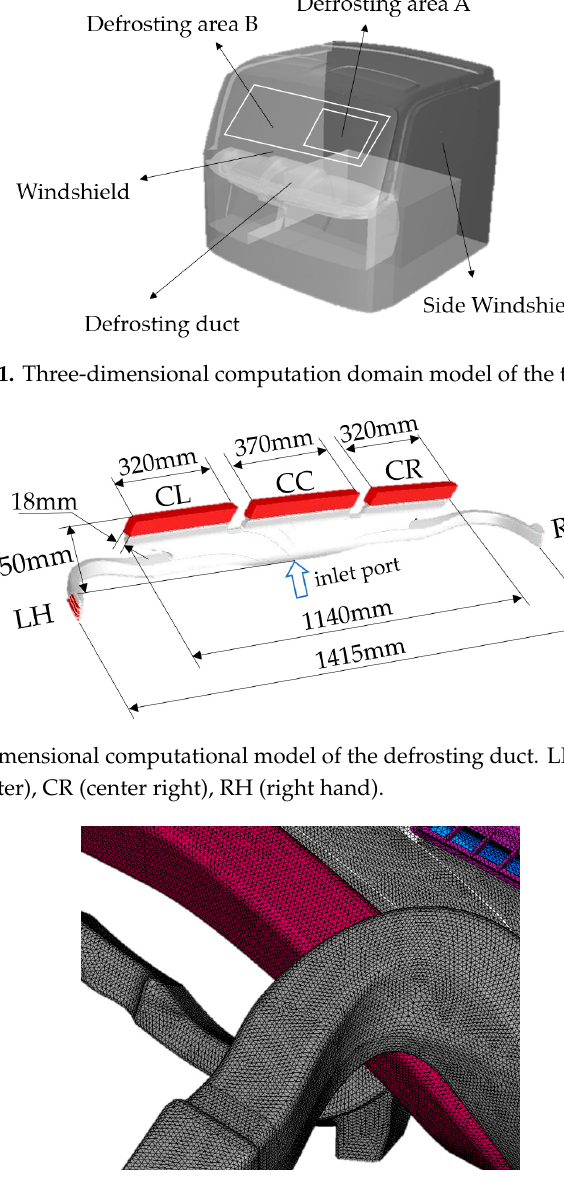
Figure 3. Local meshes of the defrosting duct surface.